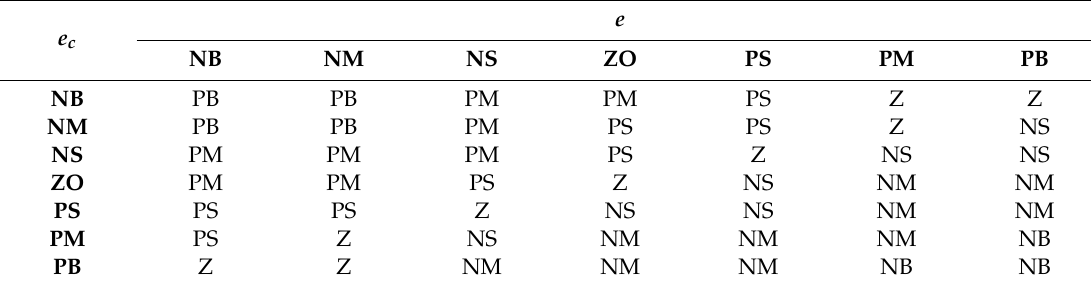
Table 1. Fuzzy rule of K p .